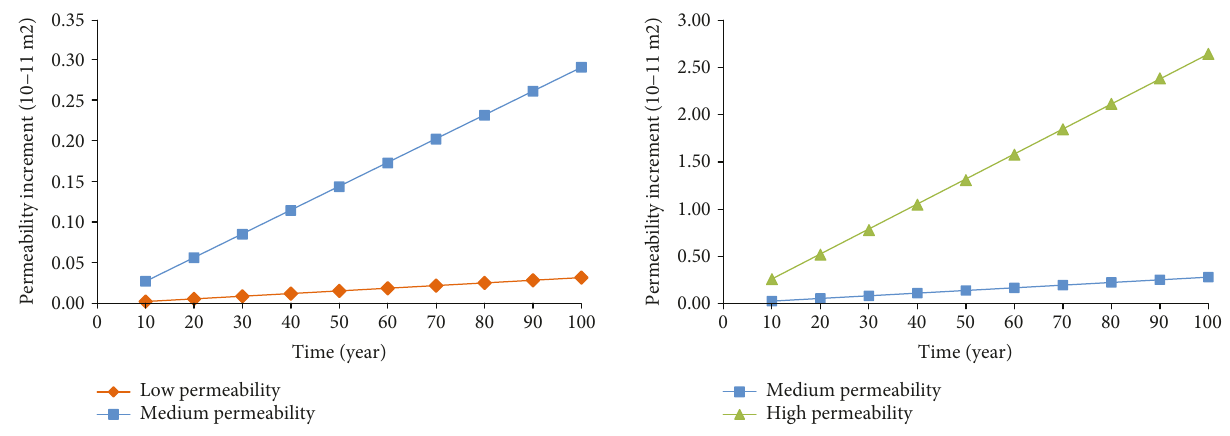
Figure 18: The rate of increase of permeability over